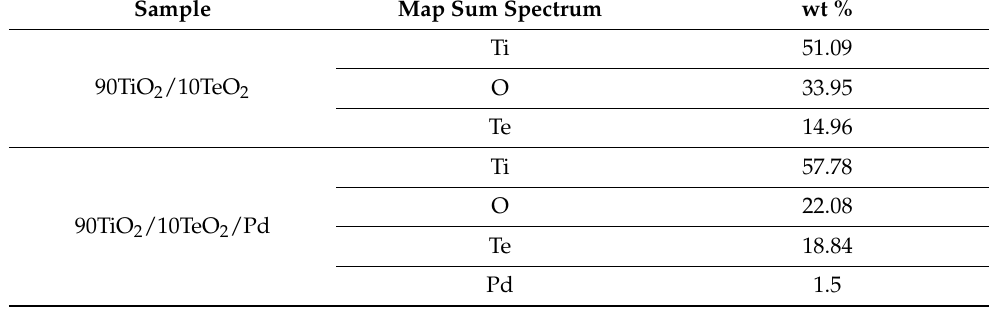
Figure 4. UV-Vis spectra of sample 90TiO 2 .10TeO 2 compared with Ti(IV) butoxide. Table 1. Investigated TiO 2 /TeO 2 gel, observed cut-off and calculated optical band gap values (Eg). - Sample